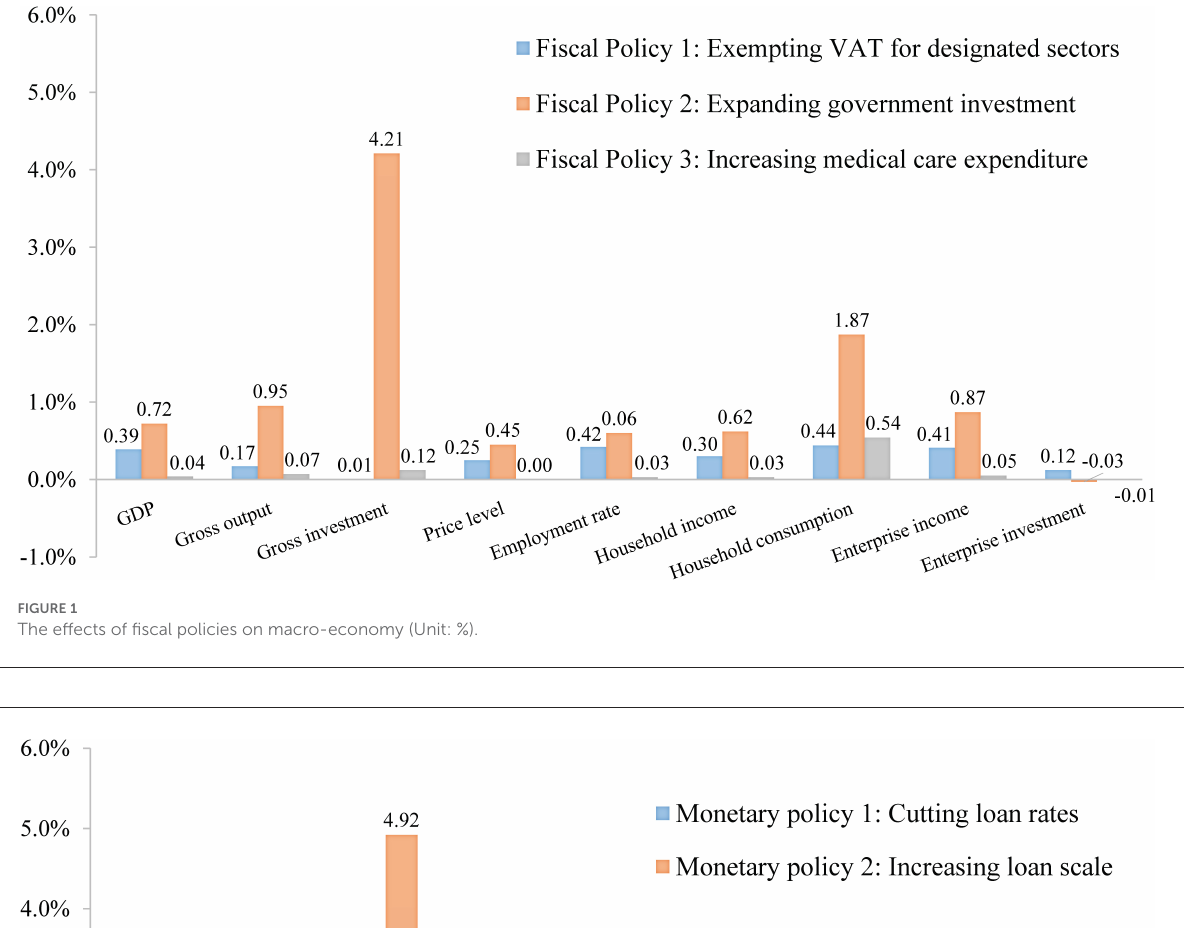
FIGURE1 The effects of fiscal policies on macro-economy (Unit: %).